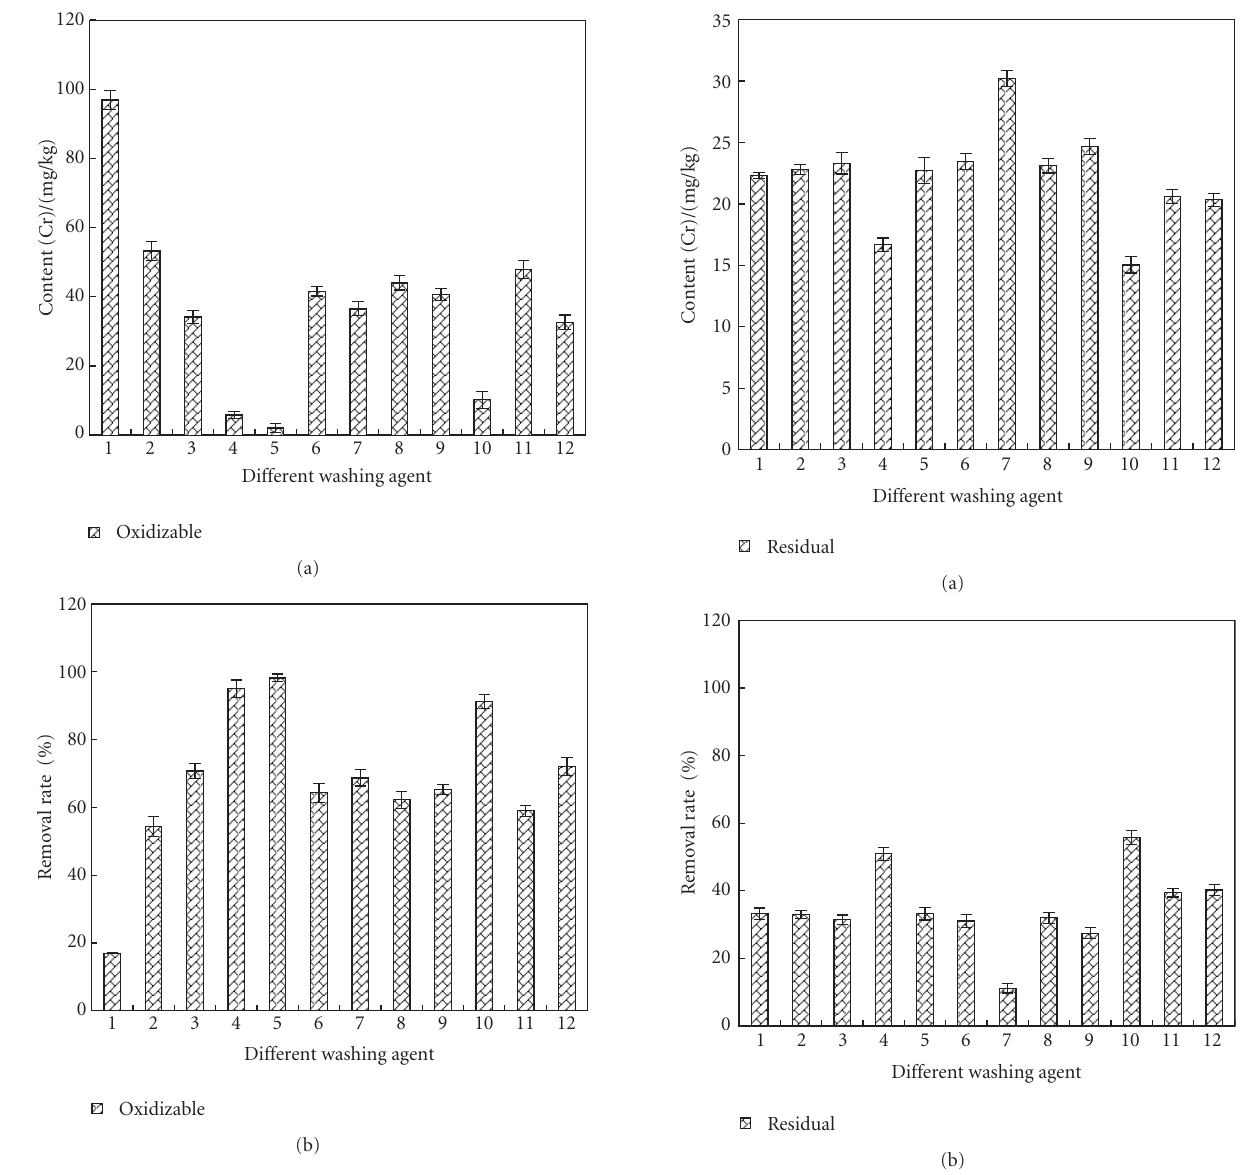
Figure 10: Removal e ff ect of oxidizable Cr by di ff erent washing agents. Washing agent: 1—water; 2—0.05 mol/L EDTA-Na 2 ; 3— 0.1mol/L EDTA-Na 2 ; 4—0.1 mol/L citric acid; 5—0.5 mol/L citric acid; 6—0.1 mol/L oxalic acid; 7—0.5 mol/L oxalic acid; 8— 0.1mol/L HCl; 9—0.5 mol/L HCl; 10—1 mol/L HCl; 11—0.1 mol/L acetic acid; 12—0.5 mol/L acetic acid.